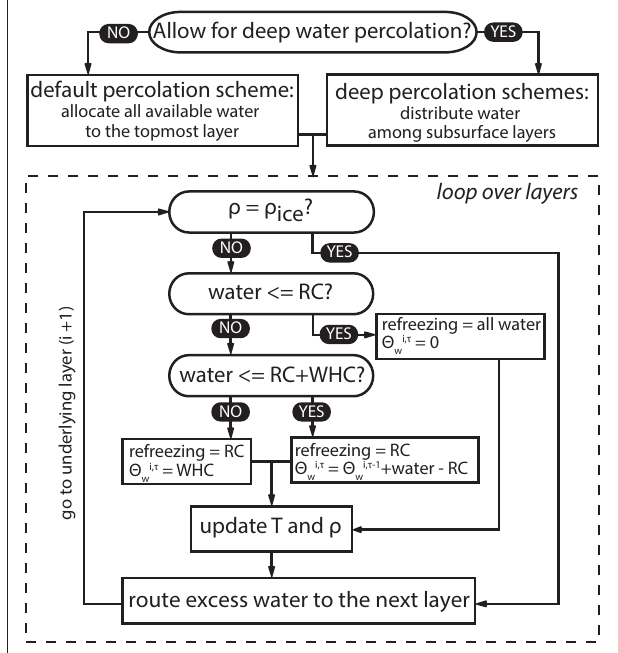
FIGURE 3 | Schematic diagram illustrating routines executed to assess the influence of liquid water refreezing on the temperature ( T ), density ( ρ ), and water content ( θ w ) of subsurface layers at one time step ( τ ). RC, refreezing capacity defined by the layer’s temperature and density; WHC, water holding capacity defined by the potential of capillary and adhesive forces to retain water within a layer against